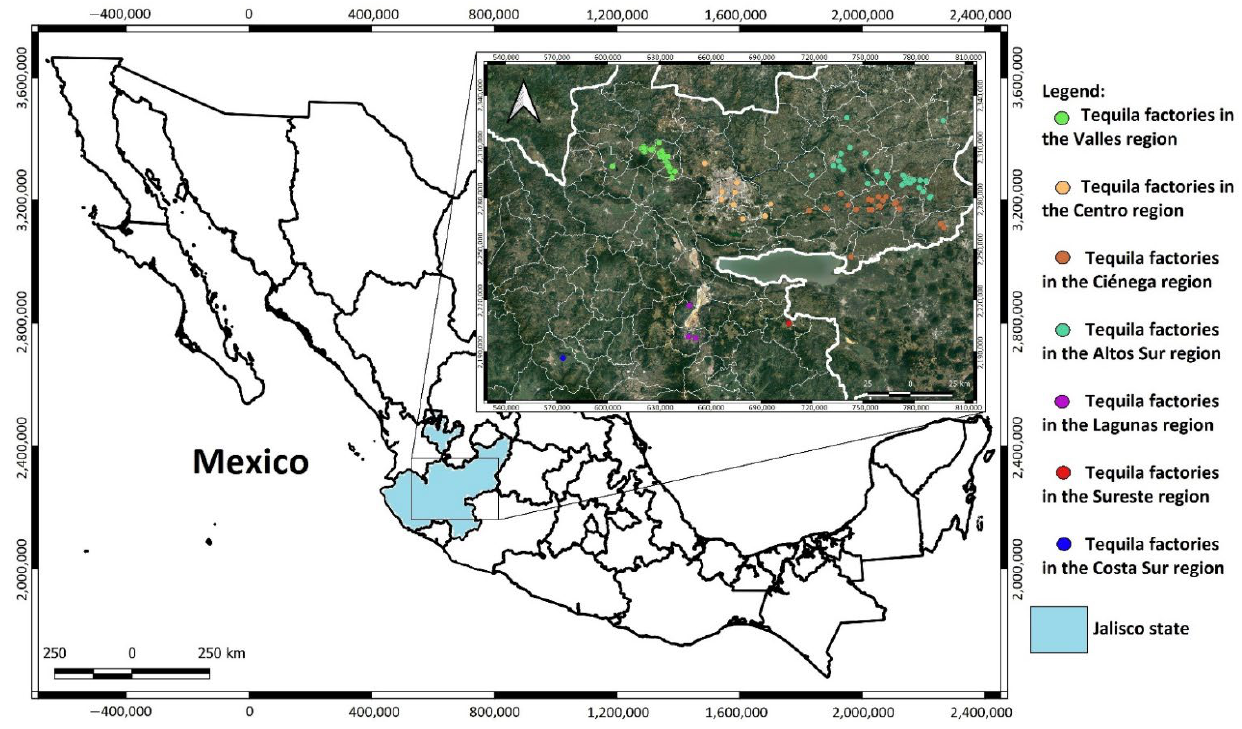
Figure 3. Tequila factories located throughout the state of Jalisco (a total of 110 facilities). Table 1. Municipalities with the largest numbers of tequila